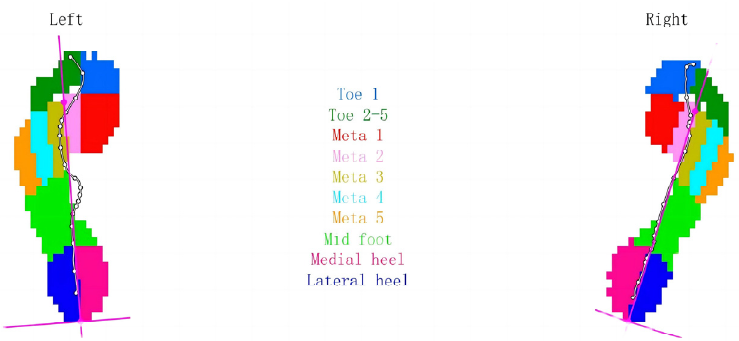
Figure 3. Plantar pressure zone diagram.